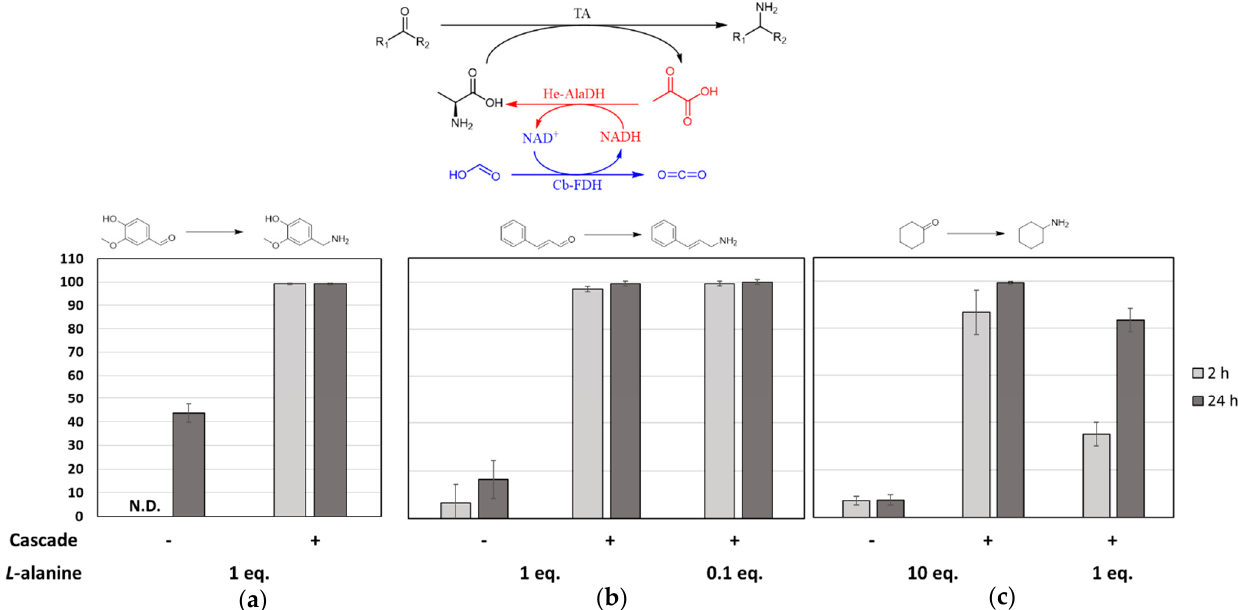
Figure 1. Conversions are expressed as % of molar conversion. The reaction performed with HeWT alone is indicated with a “ − “ while the presence of the recycling system (HeAlaDH and CbFDH) is indicated with a “ + ”. Reactions contained 2 mg/mL of HeWT, 0.5 mg/mL of HeAlaDH, 1 mg/mL of CbFDH with 10 mM of the corresponding aldehyde or ketone, 1 mM NAD + , 100 mM of ammonium formate, and the desired concentration of alanine in 100 mM phosphate buffer pH 8. N.D. refers to not detected. ( a ) Vanillin (10 mM) conversion in batch with different amounts of alanine. ( b ) Cinnamaldehyde amination with equimolar and sub-stoichiometric amount of the L-alanine as the amino donor. ( c ) Amination of 10 mM cyclohexanone with 10 equivalents or 1 equivalent of